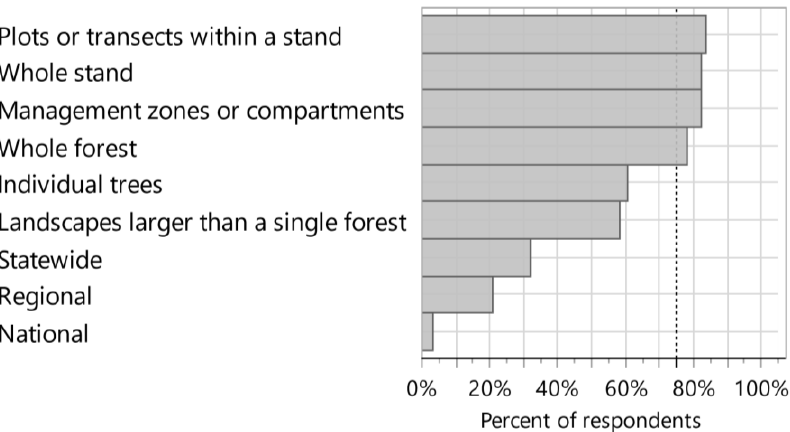
Figure 2. Spatial units for data collection and summary that are relevant to forest managers. Dotted line represents 75% of survey